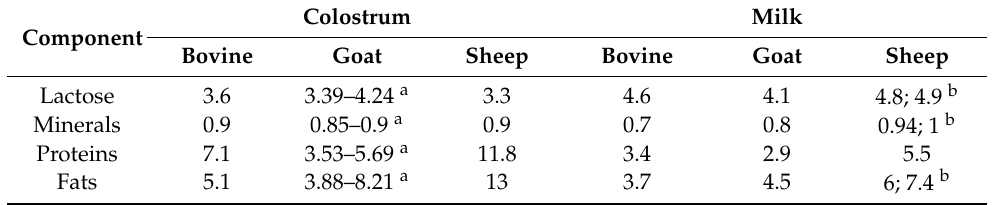
Table 1. Composition of bovine, goat, and sheep colostrum and milk (%) [3,7–13]. Colostrum Milk Component Bovine Goat Sheep Bovine Goat Sheep Lactose